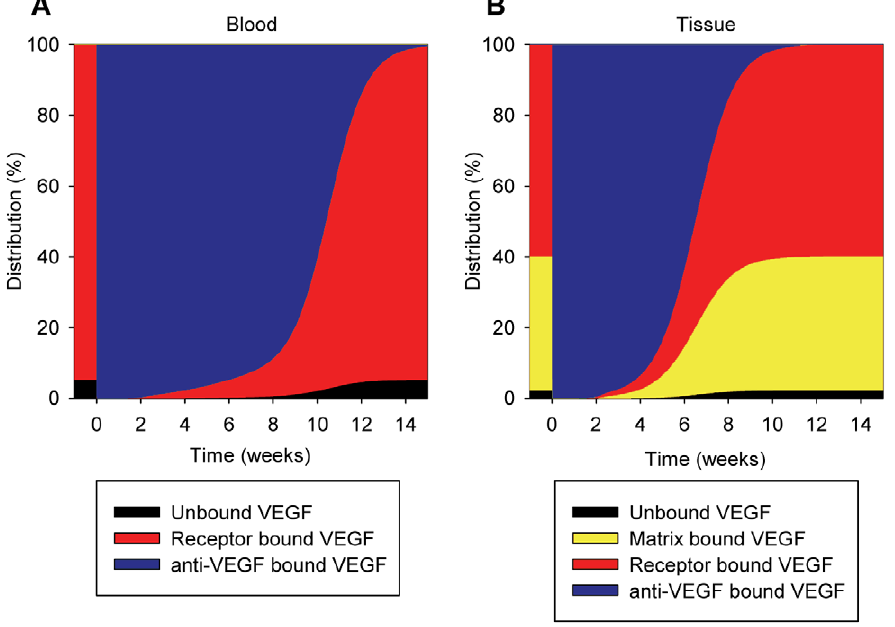
Figure 9. VEGF distributions upon injection of anti-VEGF (VEGF Trap). The distributions of VEGF in the (A) blood and (B) tissue compartments are shown subject to a 25 mg/kg injection of the anti-VEGF agent into the blood compartment at 0 weeks. Before the injection, 95% of VEGF in the blood compartment is receptor bound. In the tissue compartment, 38% of VEGF is sequestered in the extracellular matrix and endothelial and parenchymal basement membranes. 60% of VEGF is receptor-bound. Shortly following the injection of the anti-VEGF agent, essentially all of the VEGF in both compartments becomes sequestered by the anti-VEGF agent. By 14 weeks, VEGF distributions return to original steady-state